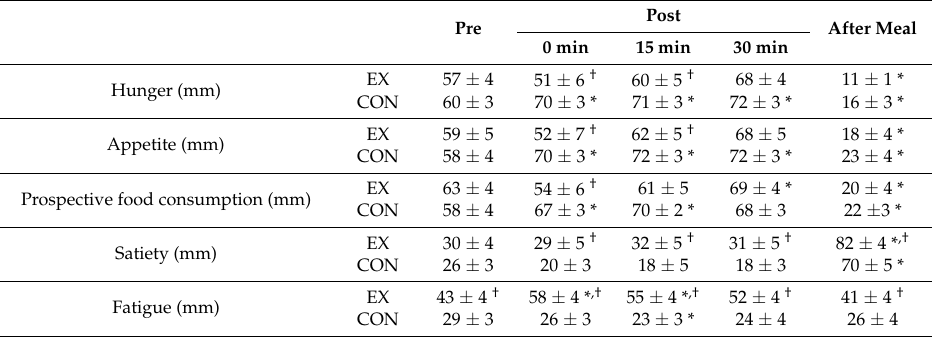
Table 1. Change in scores of subjective feeling of appetite and